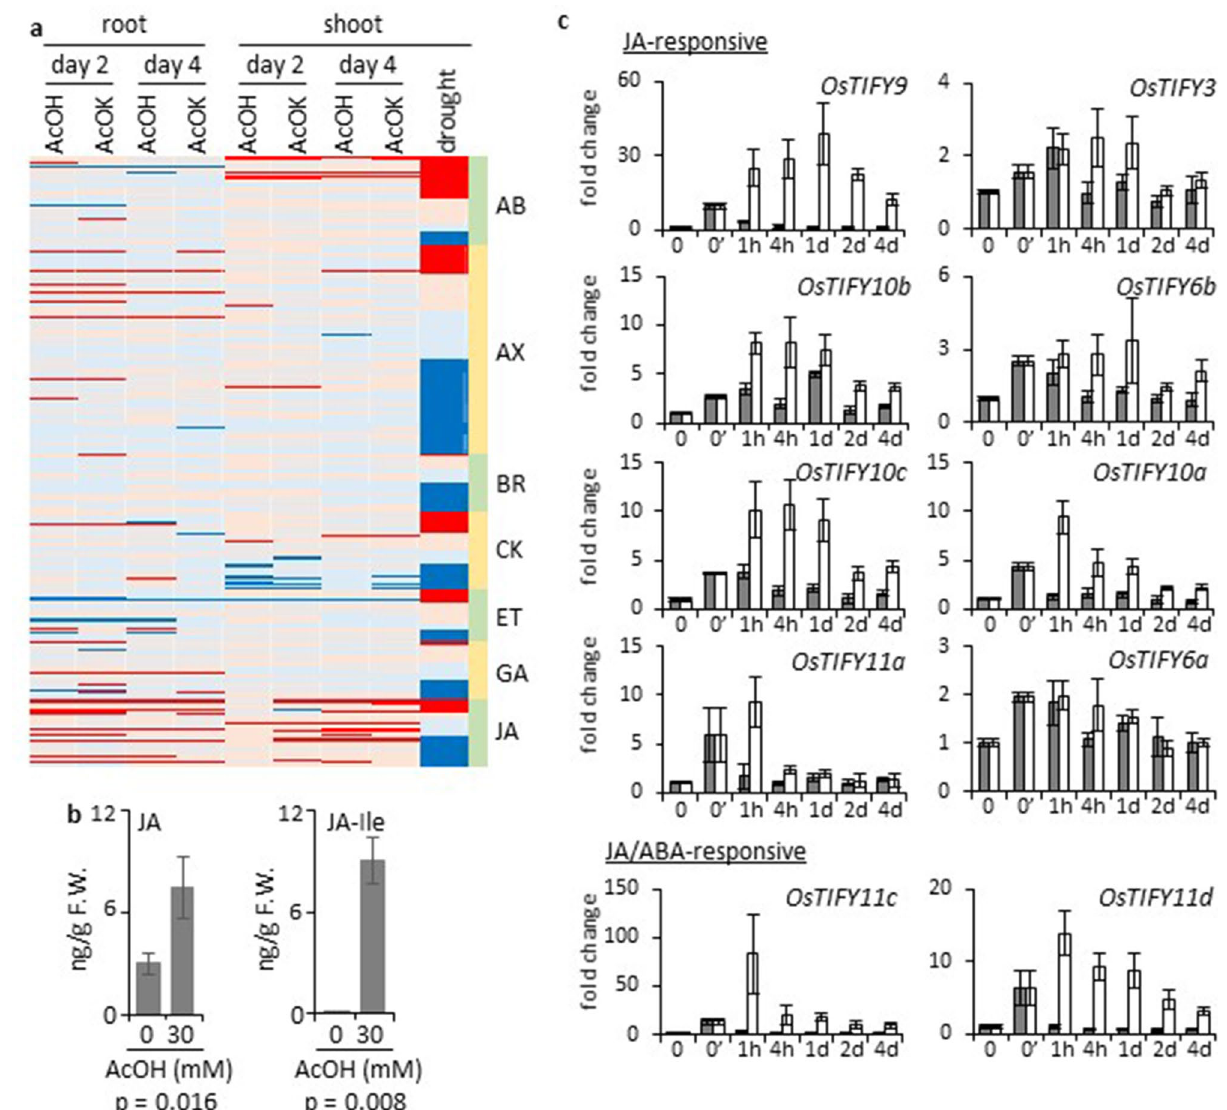
Figure 3. Jasmonate signaling is activated by acetic acid treatment of rice. ( a ) Microarray analysis was performed with RNA samples obtained from roots and shoots of rice seedlings treated with acetic acid (AcOH) or potassium acetate (AcOK) on day 2 and day 4 of the treatment. Data obtained with RNA prepared from shoots of rice seedlings under drought conditions was used for comparison. Changes in expression of genes involved in biosynthesis, signaling, or downstream effects of hormones [abscisic acid (AB), auxin (AX), brassinosteroid (BR), cytokinin (CK), ethylene (ET), gibberellin (GA), and jasmonic acid (JA)] are visualized as a heat-map (red; fold change ≥ 2, pale red; 1 < fold change < 2, pale blue; 0.5 < fold change < 1, blue; fold change ≤ 0.5). Genes related to each hormone were ordered according to their fold change under drought conditions. Details of genes and fold changes are shown in Supplementary Tables S2–S8 online. ( b ) Quantification of JA in acetic-acid-treated rice roots (30 min after application of acetic acid). Left, jasmonic acid; right, JA-Ile. Error bars, standard deviation; n = 6. Statistical significance was examined by t-test. F.W., fresh weight. ( c ) Expression analysis of TIFY / JAZ genes in acetic-acid-treated rice root by qRT-PCR. Two- week-old rice seedlings were treated with 30 mM acetic acid and total RNA was extracted from roots at the timepoint indicated (up to 4 days). Genes were classified as JA- or JA/ABA-responsive according to data in public databases (Supplementary Table S12 online). Gray bars, control water treatment; white bars, acetic acid treatment; 0, plants without treatment; 0 ′ , plants after water draining; vertical axes, fold changes. Error bars, standard deviation; n =